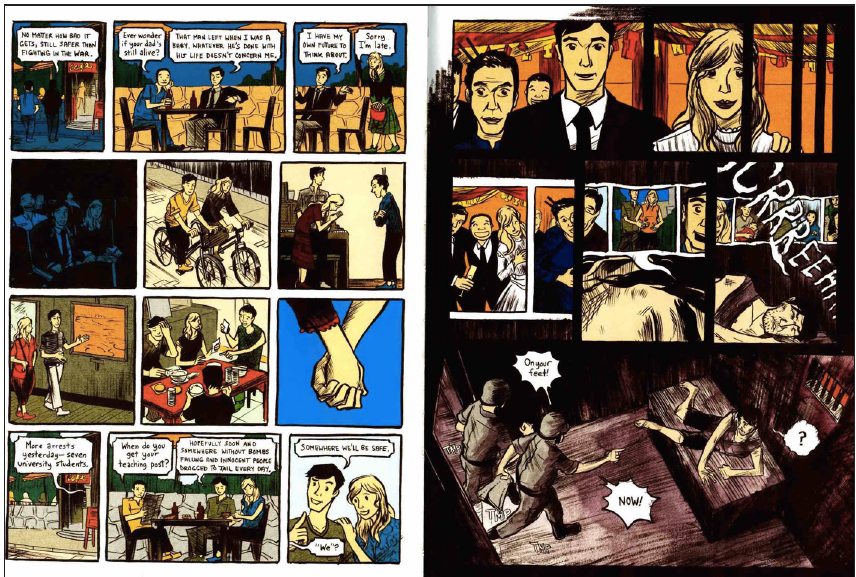
Figure 1: Tran, GB (2010) Vietnamerica (London: Villard, 88 and 89)  Gia-Bao